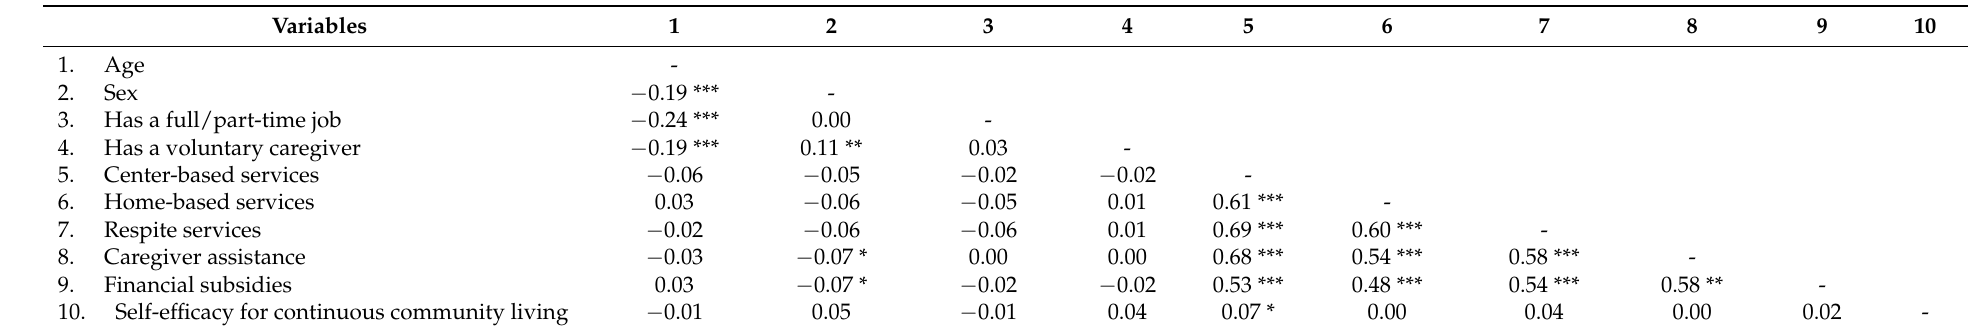
Table 4. Correlation matrices of individuals with disabilities ( n =